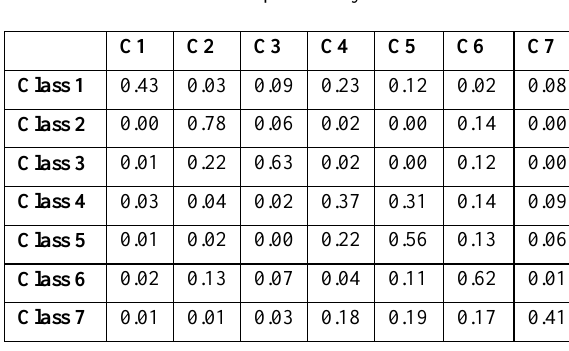
Table 3. Transition probability matrix 1991-2000